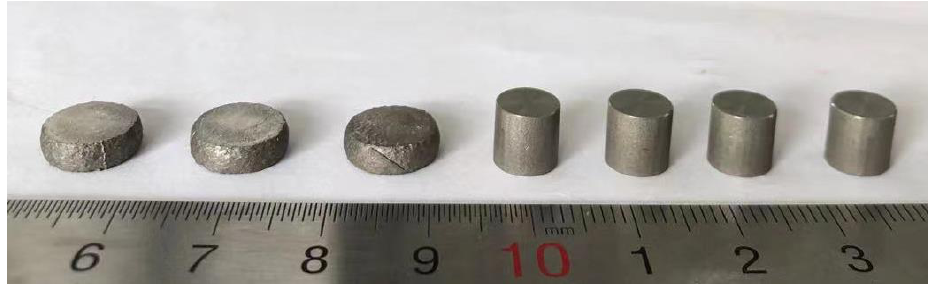
Figure 8. The Rockwell hardness of FeNiCoCr HEA samples annealed at different temperatures.